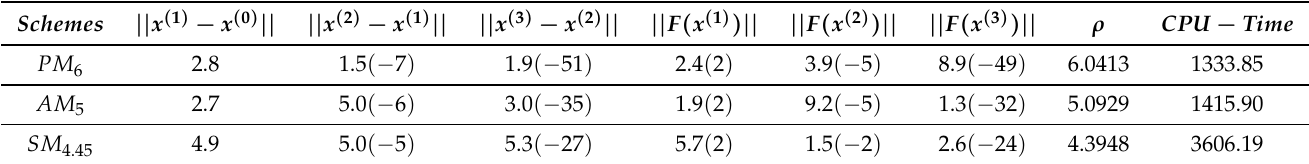
Table 4. Convergence behavior of schemes for Example